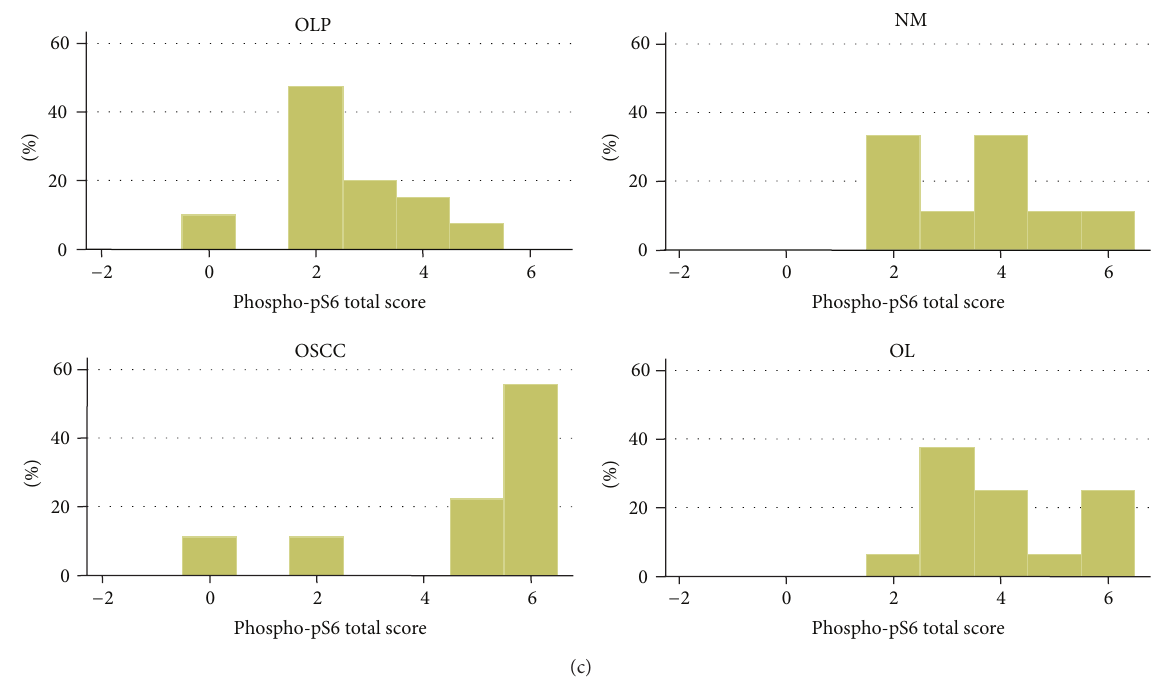
Figure 7: Graph of immunohistochemical results for phosphorylated ribosomal protein pS6 (phospho-pS6). Distribution of cases per lesion category according to (a) positivity score, (b) intensity score, and (c) total score. Abbreviations: oLP: Oral lichen planus; NM: normal mucosa; OSCC: oral squamous cell carcinoma; OL: oral